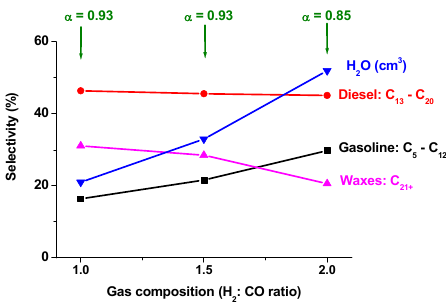
Figure 11. Impact of gas composition on FTS product fractions after 24 h on stream with catalyst samples tested at 220 °C, 2 MPa and GHSV of 3600 cm 3 ∙ g − 1 ∙ h − 1 .